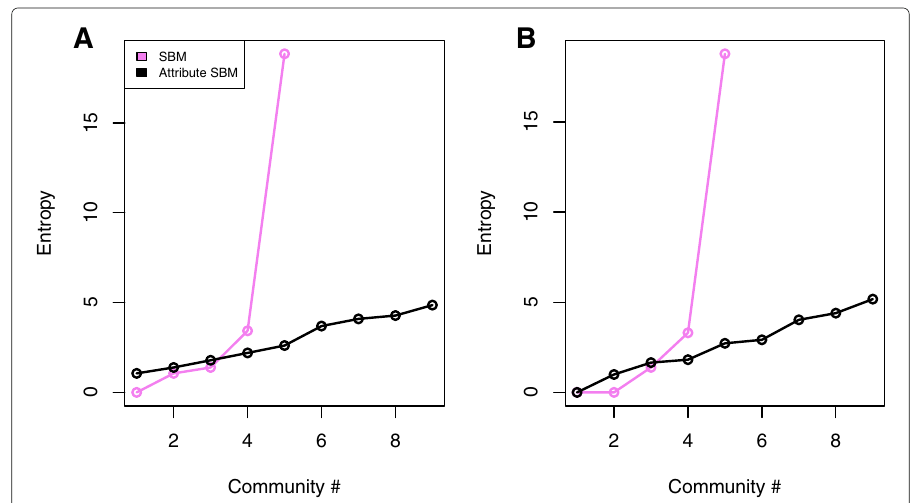
Fig. 10 Community entropies in the protein interaction network. We studied the entropy of the 2 class and 6 class classifications of the nodes in a . and b ., respectively under the classic SBM (black) and attributed SBM (purple) partitions. For A . − B . the horizontal axis denotes the community index for the particular partition. Nodes belonged to 1 of five communities under the classic SBM and belong to one of nine communities under the attributed SBM. Incorporating attributes under both classifications succeeds in breaking up a highe ntropycommunity(5) fromtheclassicSBMpartitiontolowerentropycommunities in the attributed SBM